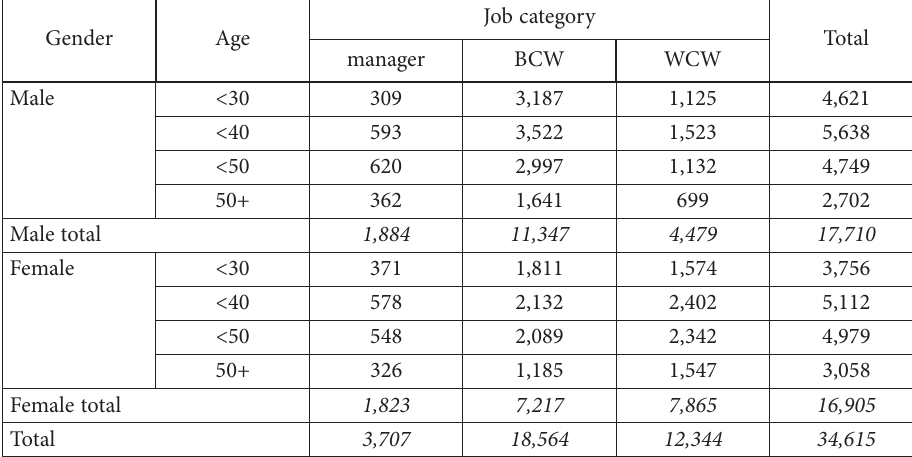
Table 1. Composition of the sample